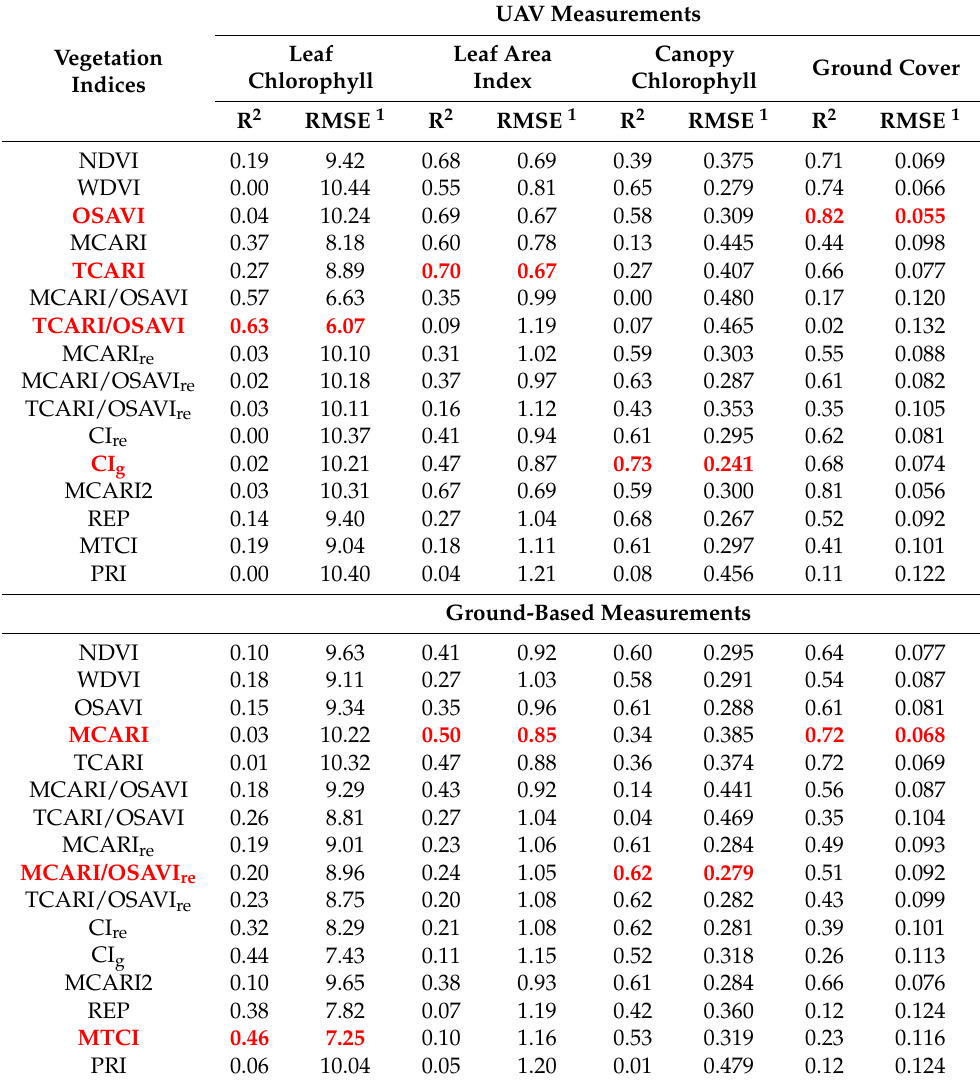
Table 3. Coefficient of determination and RMSE (from repeated 10-fold cross-validation) for linear regressions between crop traits and vegetation indices calculated from UAV and ground-based data acquired during five data acquisitions (from 43 to 99 DAP; n = 60). Indices with best prediction performance for UAV and ground data are indicated in